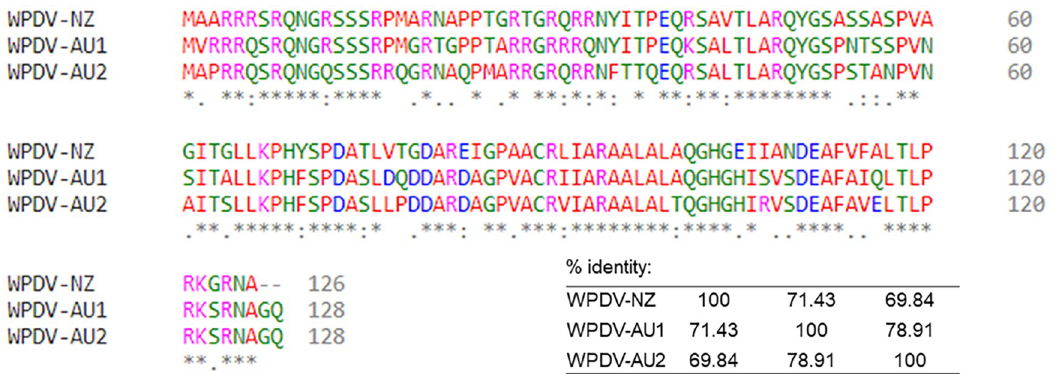
Fig 3. Multiple alignment of the predicted protein N sequences of the New Zealand and Australian Wobbly Possum Disease Viruses (WPDVs). The alignments were done in Clustal Omega using default parameters. The regions used for the alignments comprised nucleotides 12241–12627 (WPDV-AU1, GenBank accession MN635447), 12017–12403 (WPDV-AU1, GenBank accession MN635448) and 12424–12804 (WPV-NZ, GenBank accession number JN116253. The percent identity values are also